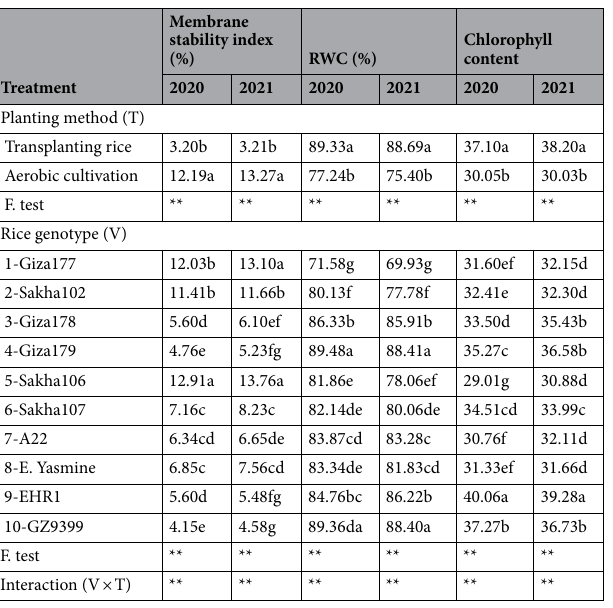
Table 7. Membrane stability index, leaf relative water content and chlorophyll of rice genotypes affected by planting methods . **Significant at 0.01 level. Means followed by a common letter at the same column are not significantly different according to Duncan ’ s multiple range at 0.05